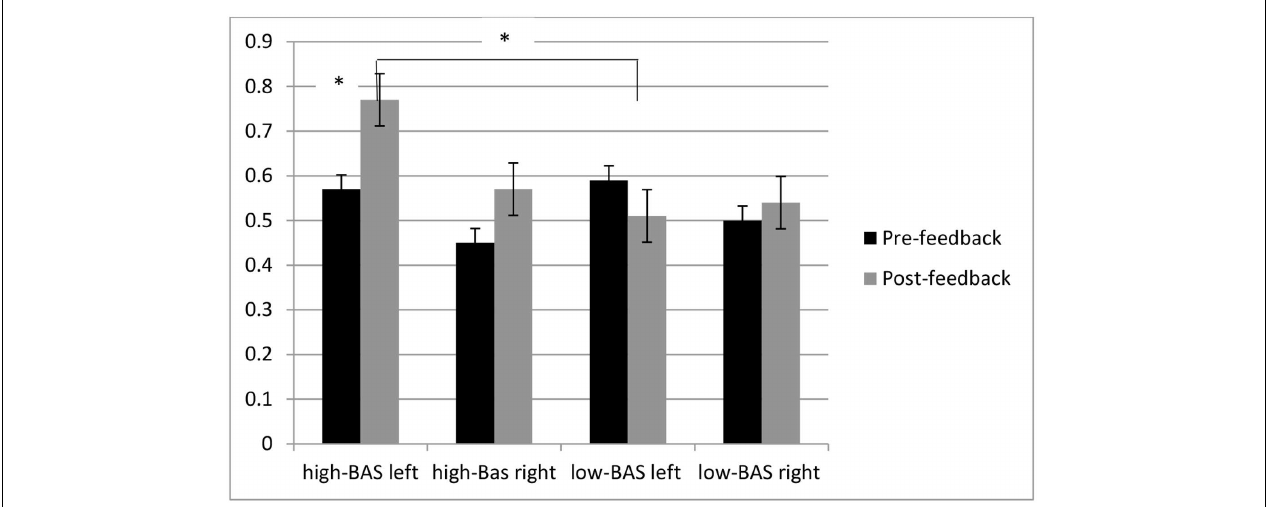
FIGURE 7 | O2Hb modulation ad a function of BAS and Condition. High-BAS showed increased left response for in post-feedback than pre-feedback condition and compared to low-BAS in post-feedback condition. Asterisk indicates significant